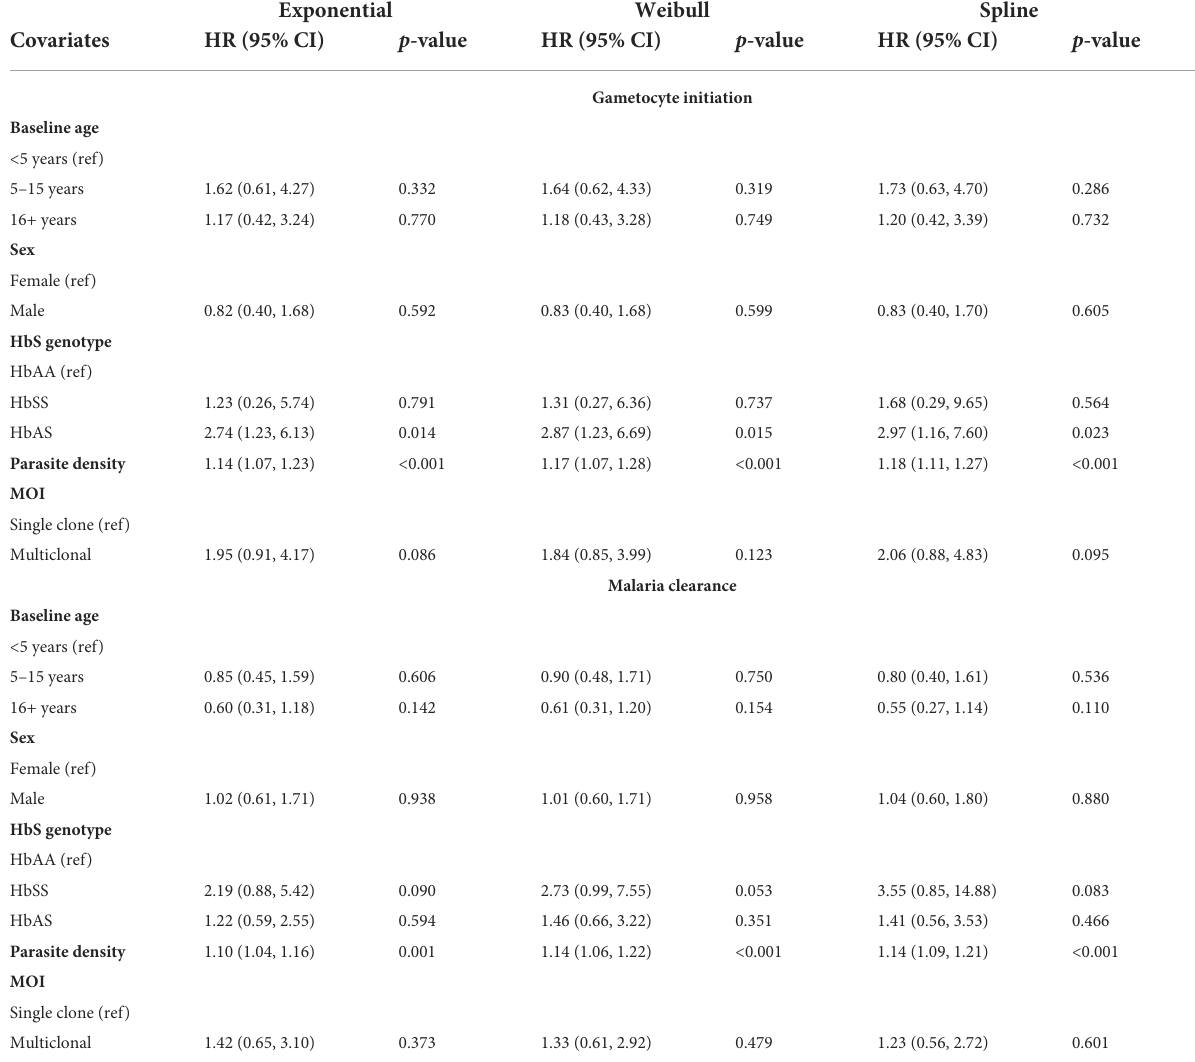
TABLE 3 Results from the malaria data analysis.